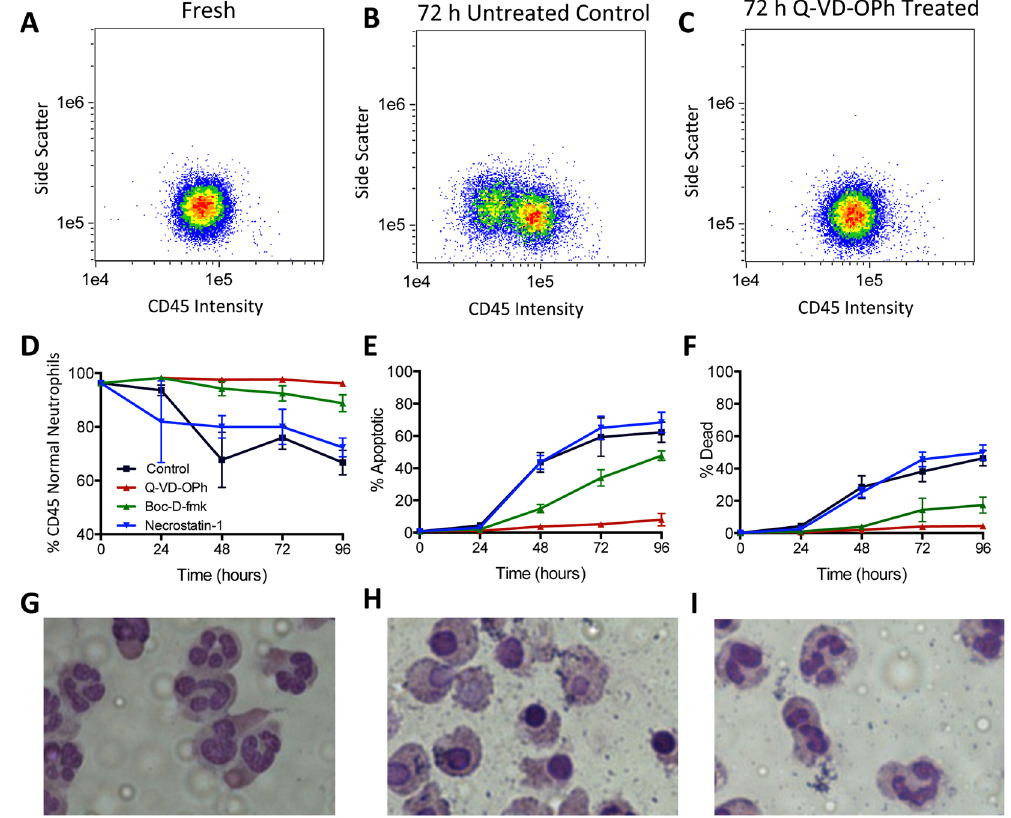
Figure 2. Evaluation of preservatives to stabilize neutrophils. ( A ) CD45 and side scatter of neutrophils isolated immediately after blood collection was determined using flow cytometry for comparison to those stored under ambient conditions in culture media using flow cytometry. ( B ) Neutrophils stored for 72 h without supplementation demonstrate CD45 degradation. ( C ) Neutrophils supplemented with the Q-VD-OPh inhibitors (n = 4 independent healthy donors, plotted as average ± standard error). Representative image of isolated neutrophils taken ( G ) immediately after blood collection compared to those stored for 72 h ( H ) without supplementation or ( I ) supplemented with Q-VD-OPh shows improved nuclear morphology compared to the untreated